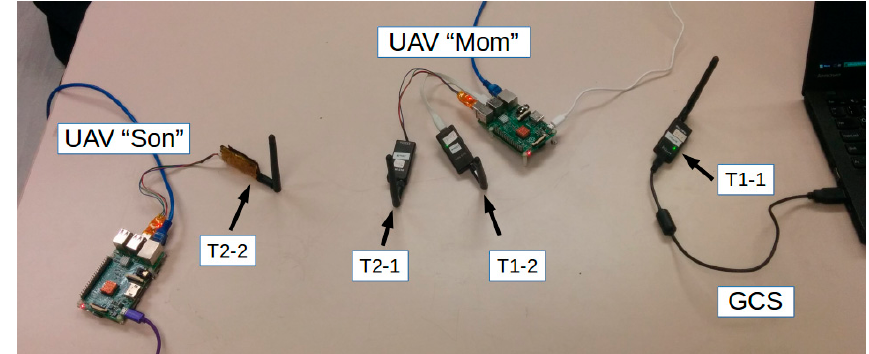
Figure 14. Radio communication relay testing setup.